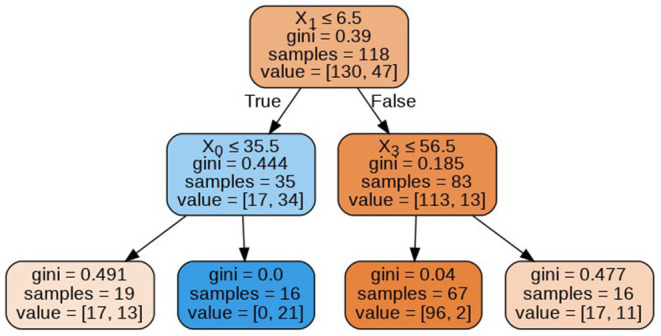
Decision tree 1.